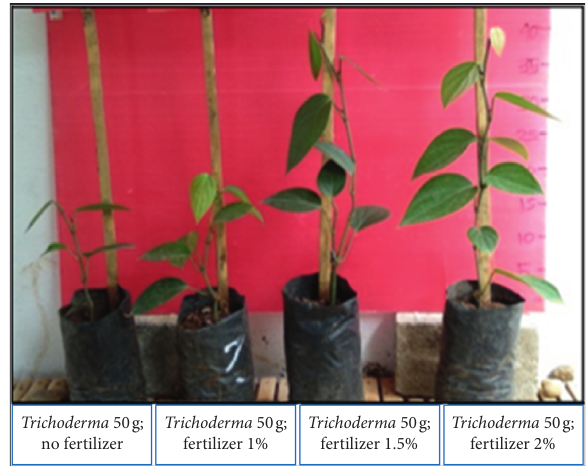
Figure 7: The length of the shoot of black pepper seedlings (after 8 weeks of planting) in combination with Trichoderma 50g/plant at various concentrations of the foliar